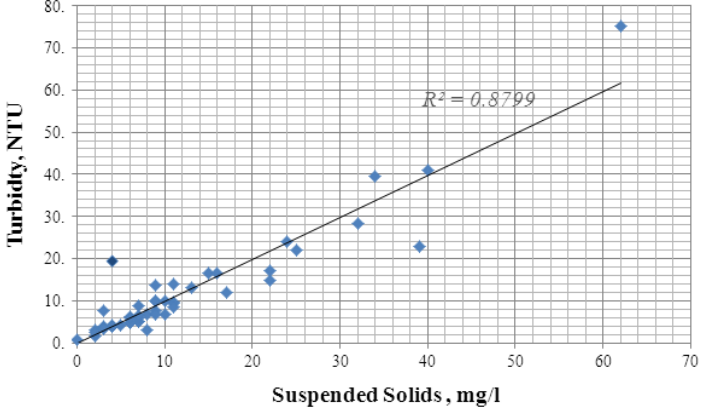
Figure 4. Relationship between mean inflow concentrations for Turbidity (NTU) and Suspended Solids (mg/L) for Filter Rig No. 1.